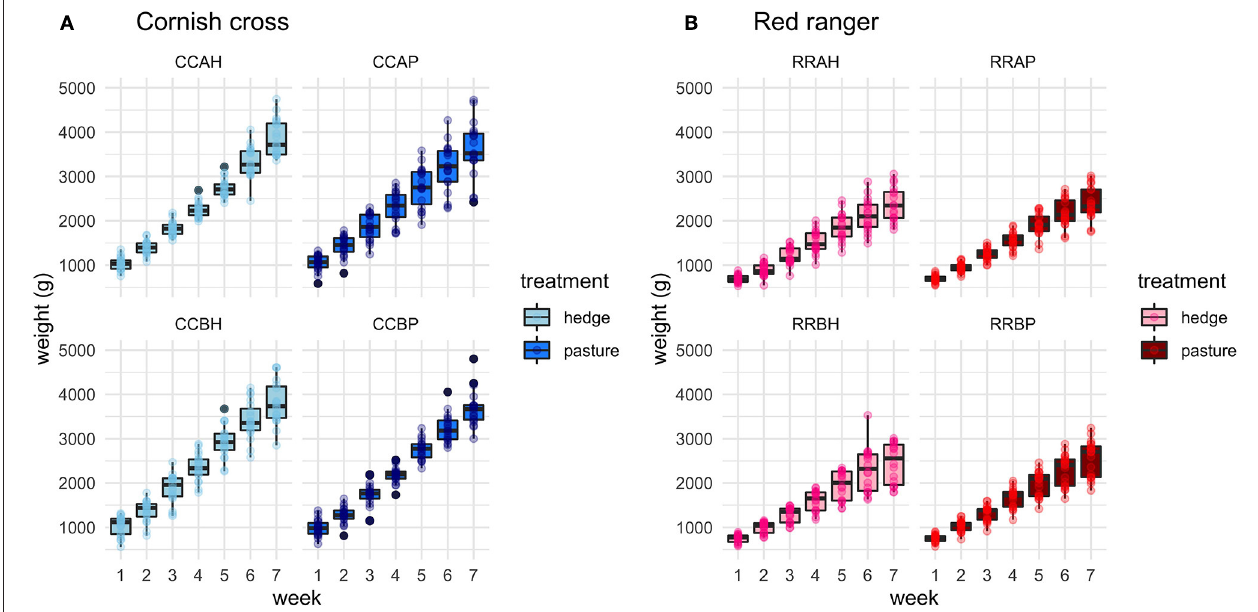
FIGURE 3 | Delineated effect of treatment on weight gain per week for each of the 8 populations, separated by breed. (A) CCAH, CCBH represent Cornish cross treatment groups. CCAP, CCBP represent Cornish cross control groups. (B) RRAH, RRBH represent Red ranger treatment groups. RRAP, RRBP represent Red ranger control groups.